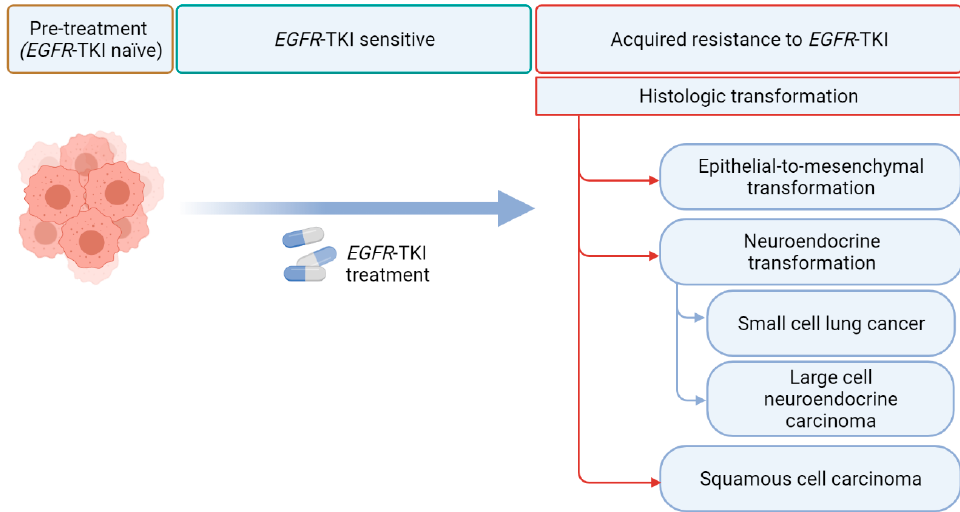
Figure 1. Histological transformation via EGFR tyrosine kinase inhibitors (TKI). EGFR refers to epidermal growth factor receptor (created with Biorender.com).